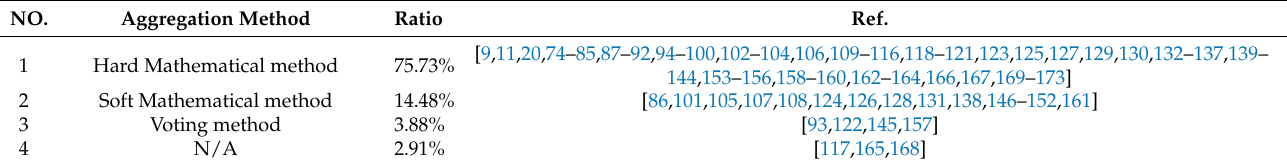
Figure 16. The topic distribution of the proportion of ranking methods. Aggregation is the final step to determine alternatives after sorting, and can be di- vided into the Hard Mathematical method, Soft Mathematical method, and Voting method, according to [31]. Table 9 shows the usage frequency of all aggregation methods. The usage frequency of the Hard Mathematical method is 75.73%, and this is the most commonly used aggregation method. Both the Soft Mathematical method and Voting method are at lower levels, accounting for 14.48% and 3.88%, respectively. Table 9. Summary of the proportion of aggregation methods.